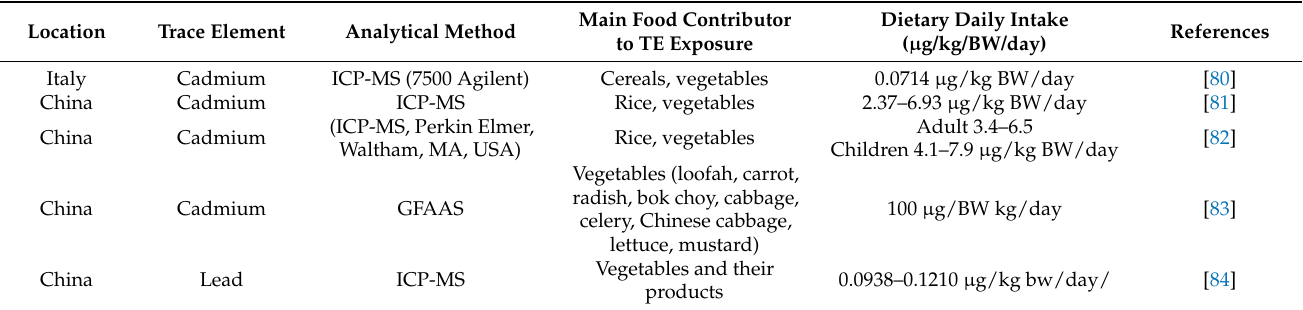
Table 5. Dietary intake of cadmium and lead and their main food contributors from previous studies